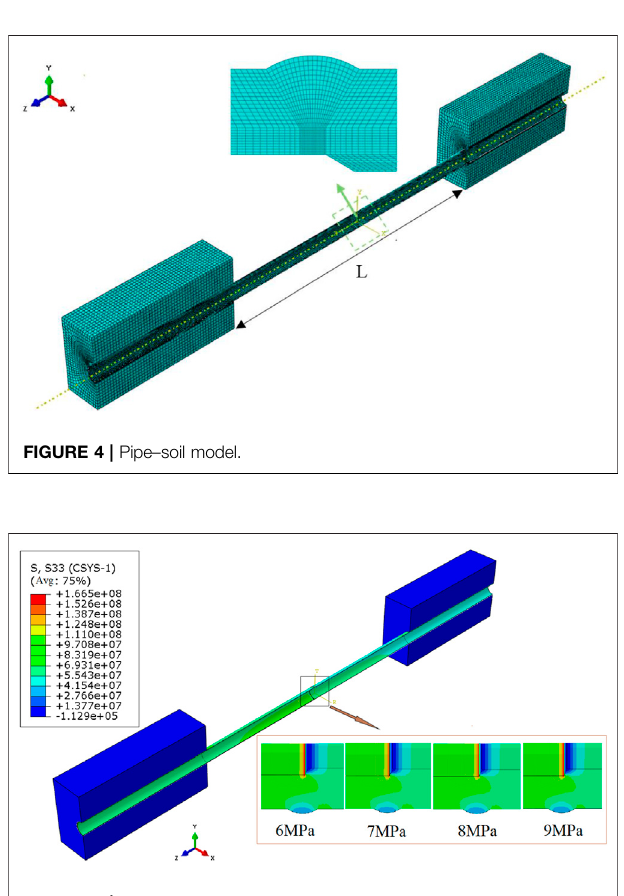
FIGURE 5 | Stress nephogram in fl uenced by internal pressure.